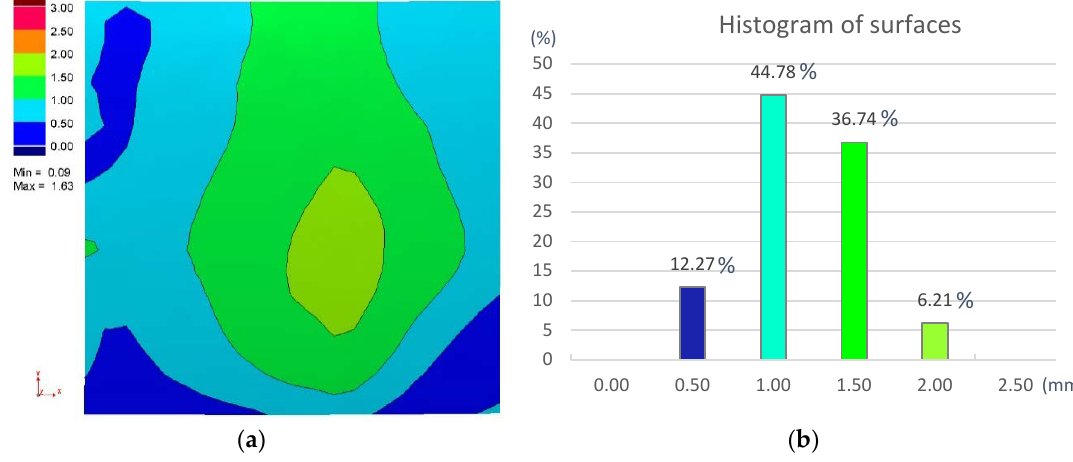
Figure 13. Simulation of Piece 2: ( a ) Distance between Real Part and Simulated Part with Die2, material characterization MP2, rolling direction parallel to the X-axis and hardening law according to Krupkowsky. ( b ) Histogram bar chart depicting the surface percentage with lower deviations than 0.5, 1.0, 1.5, and 2.0 mm, measured between the real and simulated blank.